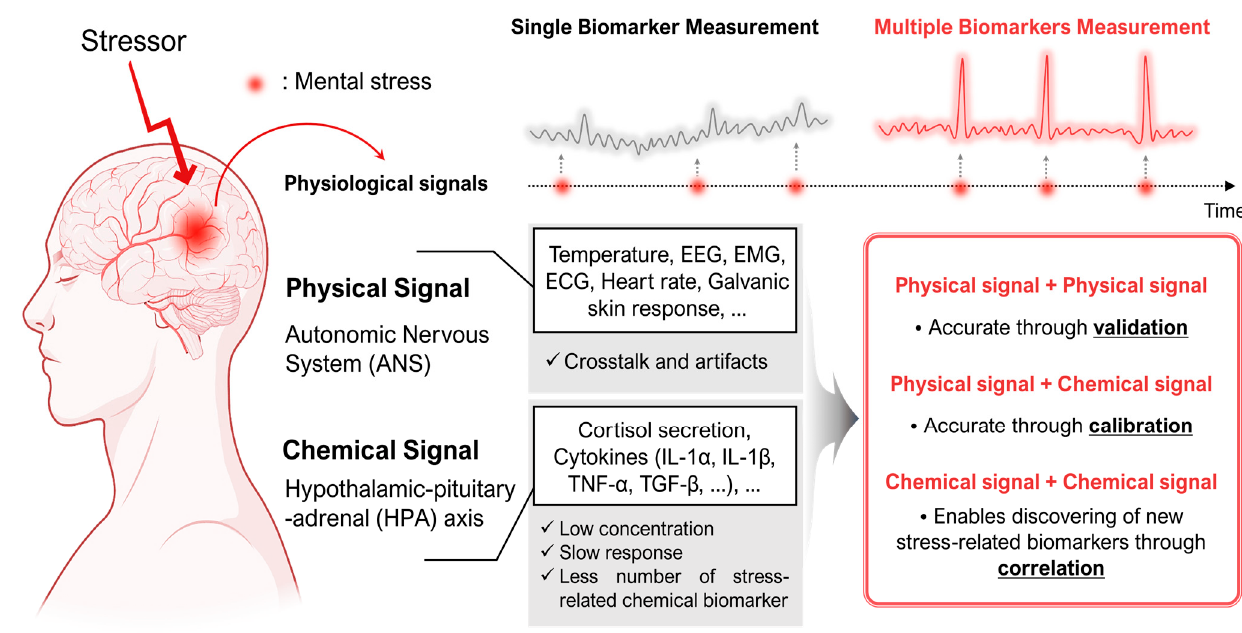
Figure 1. Mental stress triggered in response to the stressor and an illustration of the stress-related signals. Red box indicates the advantages of measuring multiple stress-related biomarkers.